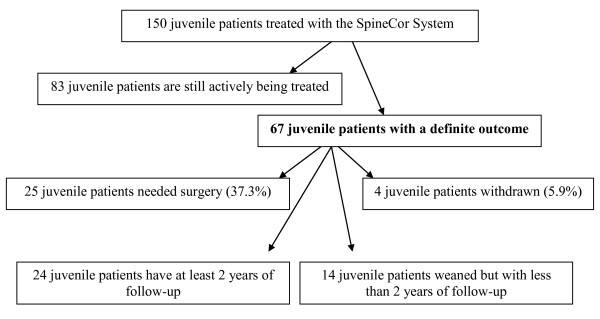
The studied population.